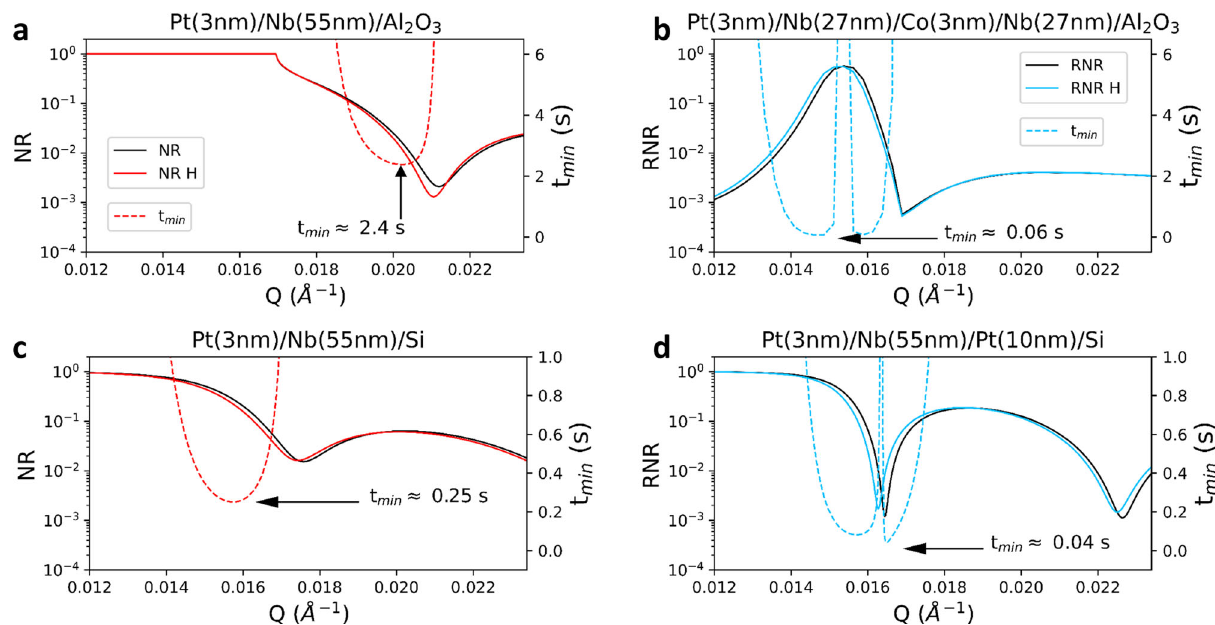
Fig. 4 Hydrogen sensitivity of NR and RNR in different systems. a Simulated NR curves for the Pt-capped Nb fi lm on sapphire before (black) and after (red) loading with 5 % hydrogen, with SLDs of 3.91 (3.81) × 10 − 6 Å − 2 for pure (5% H-loaded) Nb, respectively. b Simulated SF re fl ectivity at resonance for the same system (with an additional thin Co layer) before (black) and after (blue) H-loading. c Simulated NR re fl ectivity curves for the same fi lm on a silicon substrate. d Simulated RNR curves of a Nb fi lm on silicon, with an additional Pt layer at the substrate interface that generates a waveguide structure, before (black) and after (blue) loading with 5% H. The minimum measurement times ( t min ) to detect 5% H are shown as dashed red (blue) lines in conventional NR (RNR). Table 1 Comparison between methods for direct detection of hydrogen in thin fi